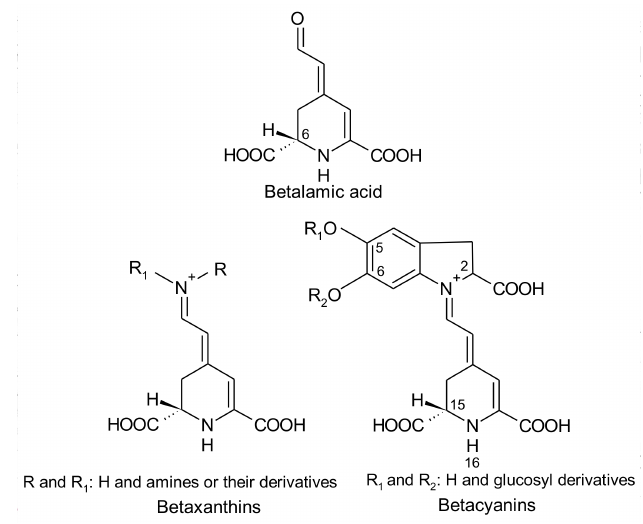
Figure 1. Structures of betalamic acid, betaxanthins and